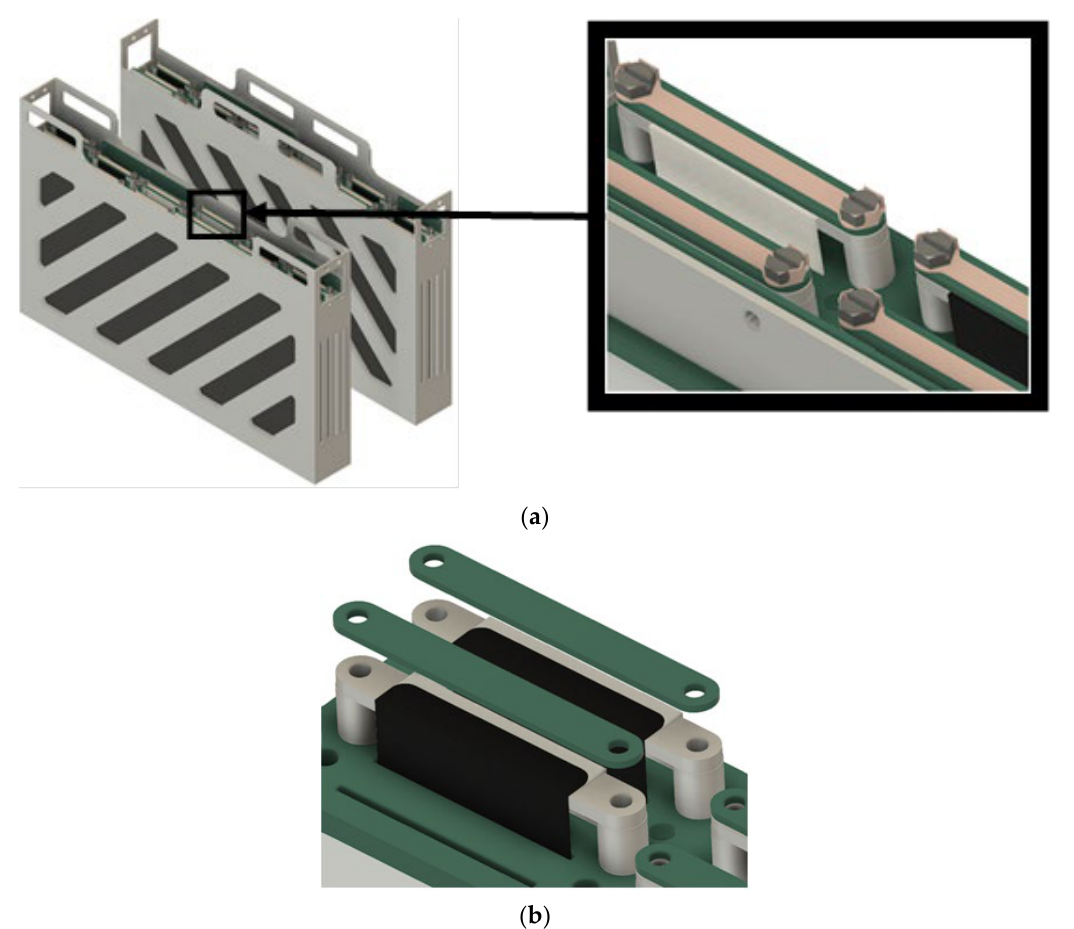
Figure 10. Cell connection using cell tabs. ( a ) Cell connection in series. Double tab washers are used to make sure that the bolts do not loosen due to vibration; ( b ) connections of cell tabs are made by bending the cell tabs over a standard bus bar. This eliminates the need to punch holes in the cell tabs, which might damage the cell tabs.